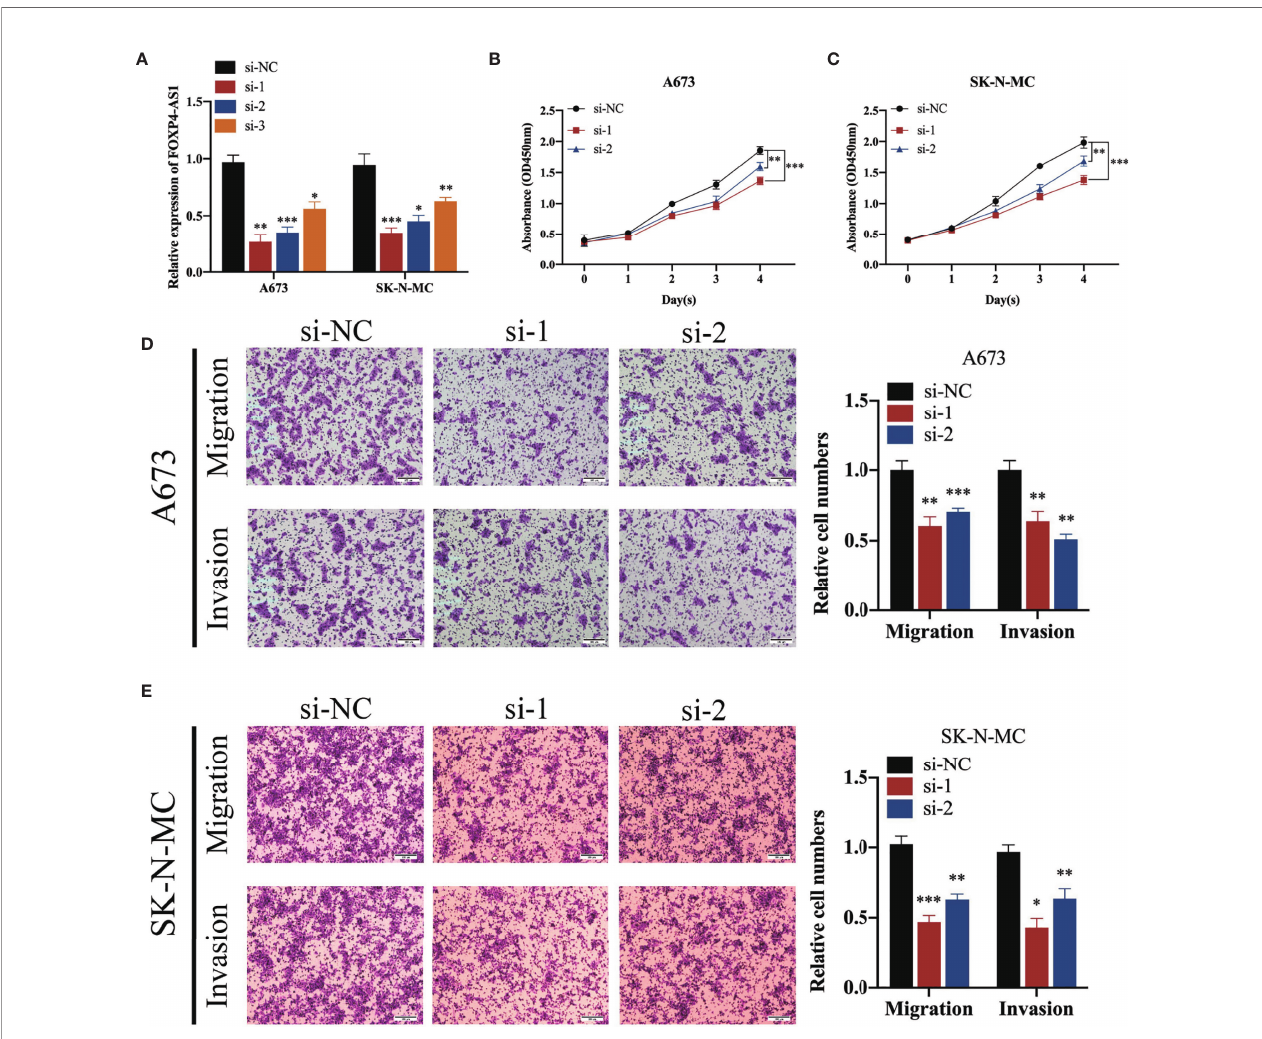
FIGURE 2 | FOXP4-AS1 knockdown suppresses proliferation, migration, and invasion ability of ES cells. (A) FOXP4-AS1 was downregulated in ES cells after transfection with siRNA. (B, C) CCK-8 assay revealed that down-regulated FOXP4-AS1 suppressed the cell proliferation of ES. (D, E) Transwell assays revealed that knockdown of FOXP4-AS1 by siRNA signi fi cantly prevented migration and invasion of ES cells. *p < 0.05, **p < 0.01, ***p <